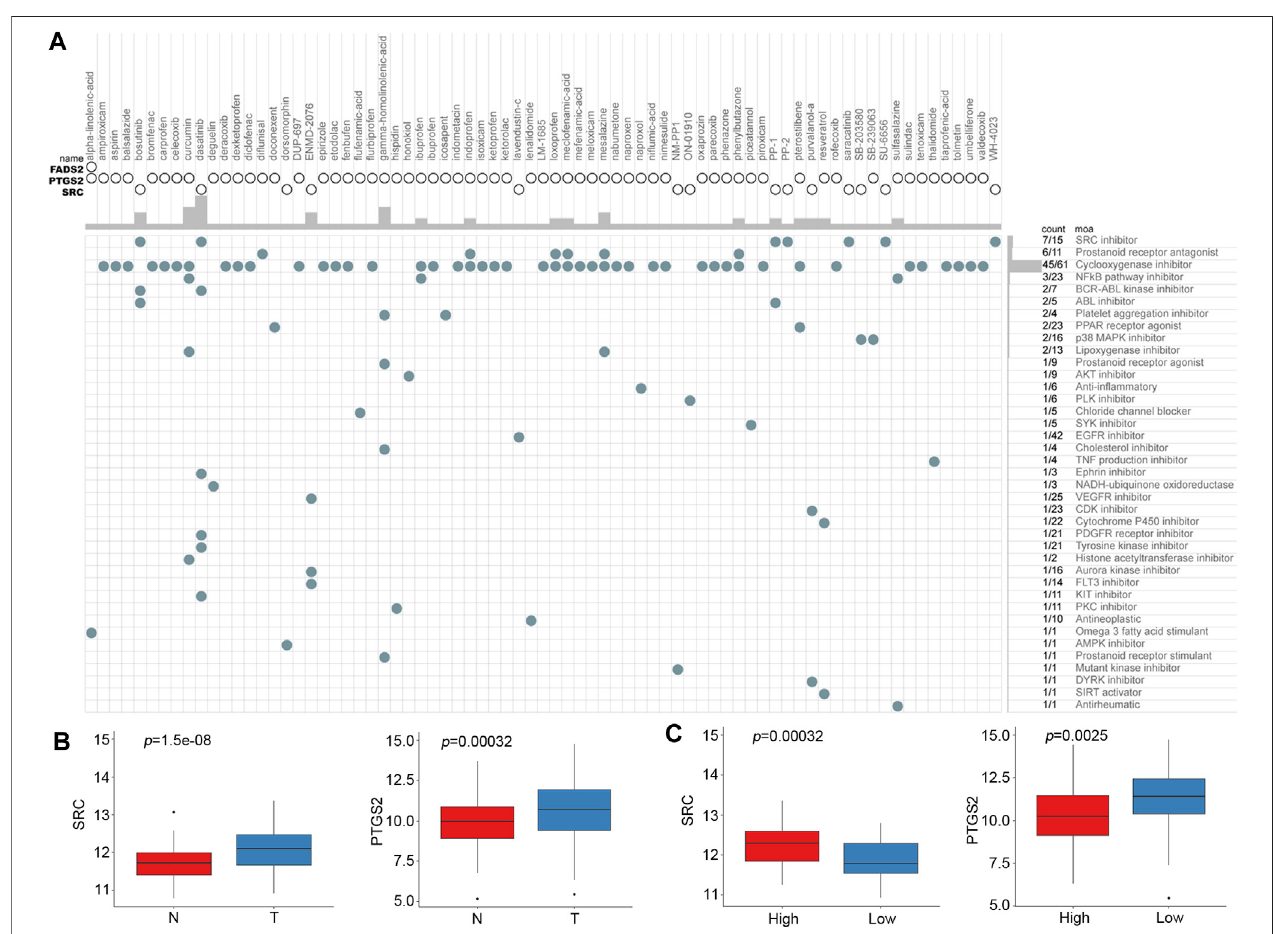
FIGURE 9 | CMap analysis identi fi ed potential compounds capable of targeting FRGs in ESCC. (A) The heat map shows each compound (column) of the shared action mechanism (row)inCMap. (B) mRNAexpression levelsofSRCand PTGS2betweennormaland cancertissues. (C) mRNAexpression levels ofSRCandPTGS2 between the low-risk and high-risk